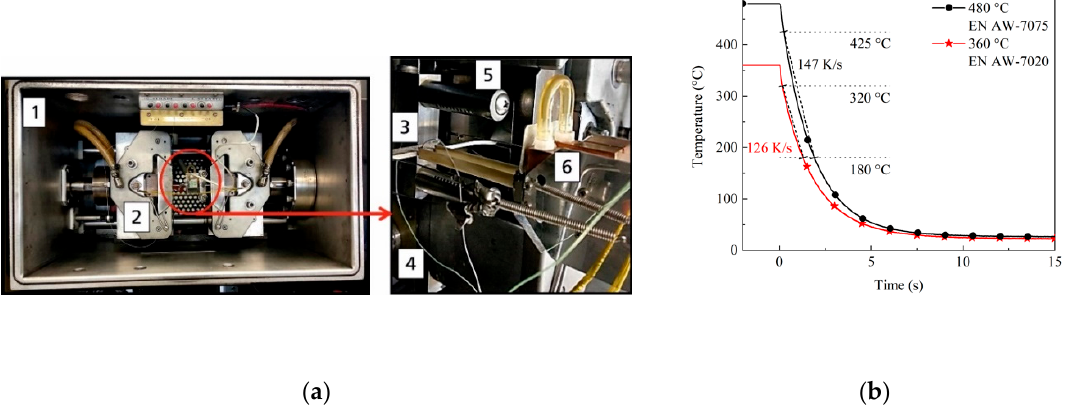
Figure 2. ( a ) Gleeble test setup: 1. test chamber, 2. steel jaws, 3. specimen, 4. thermocouple, 5. quench system, 6. Extensometer. ( b ) Temperature decrease during air quenching from two different heat treatment temperatures in the Gleeble and average cooling rates achieved in the critical temperature ranges for the two investigated alloys.